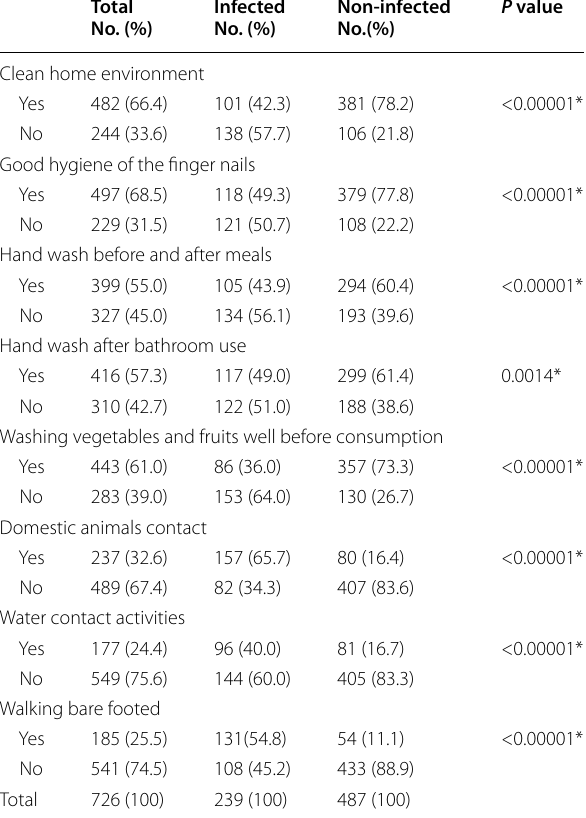
Table 3 Environmental and behavioral risk factors of parasitic infection among studied children